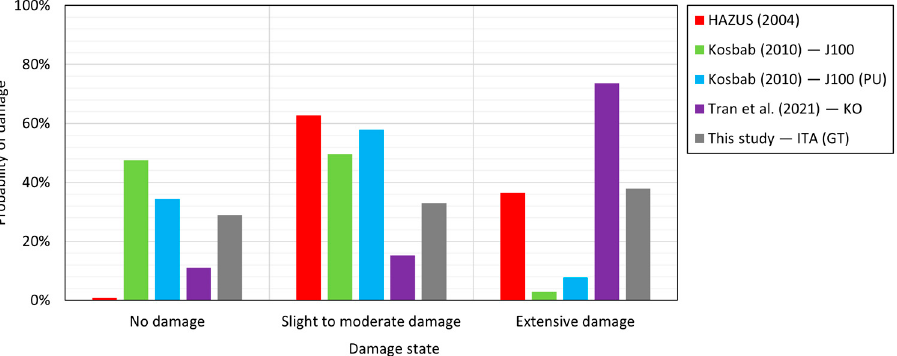
Figure 12. Comparison of damage on container cranes based on a selected scenario earthquake. PU: Portal Uplifting. KO: Korean, GT: Gioia Tauro.